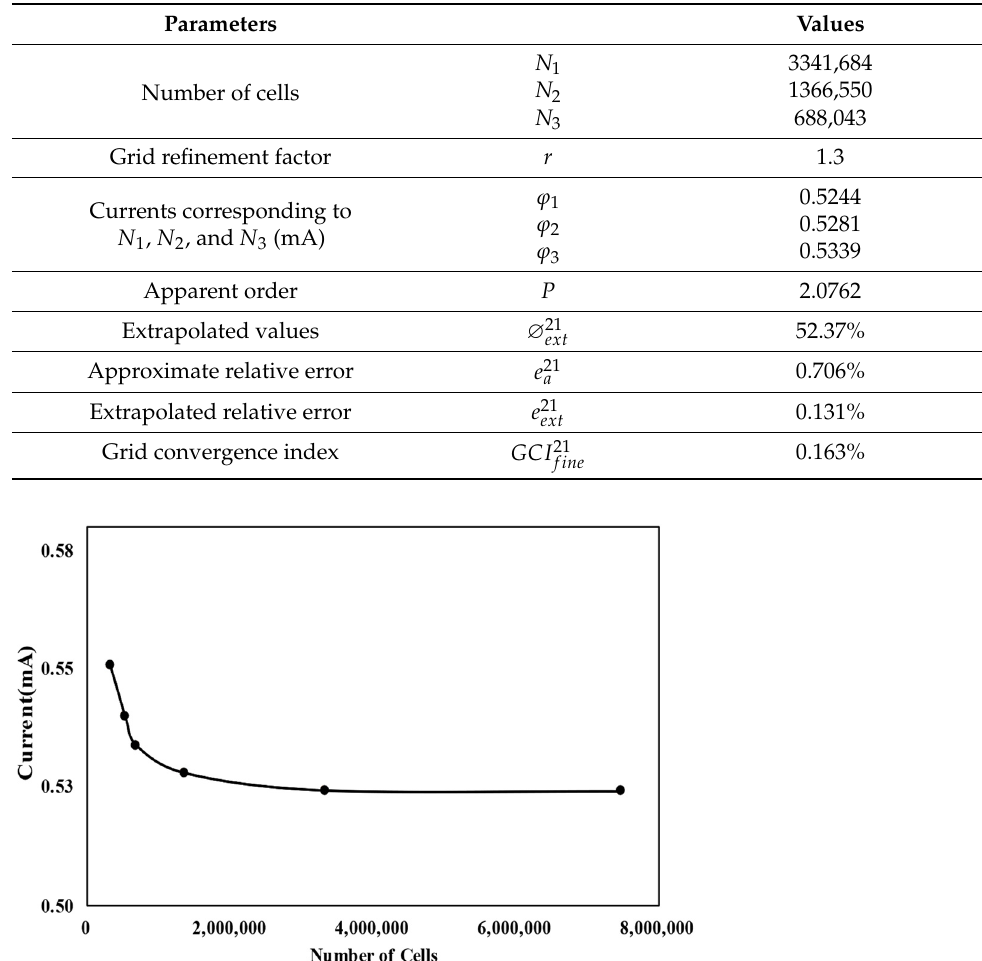
Table 5. Grid convergence index (GCI) analysis for the MMFC current [30].